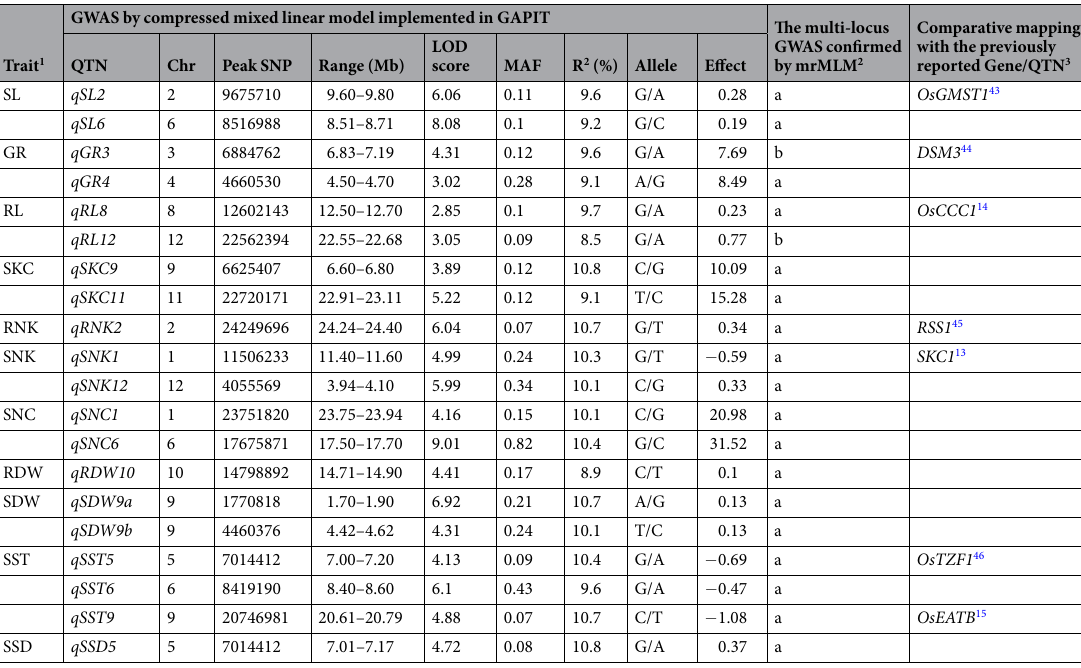
Table 4. QTN identified for salt tolerance related traits measured at germination and seedling stages. 1 Same as in Table 1. 2 a = loci confirmed by mrMLM, b = additional loci detected by mrMLM. 3 Numbers on top right corner of genes are serial number of